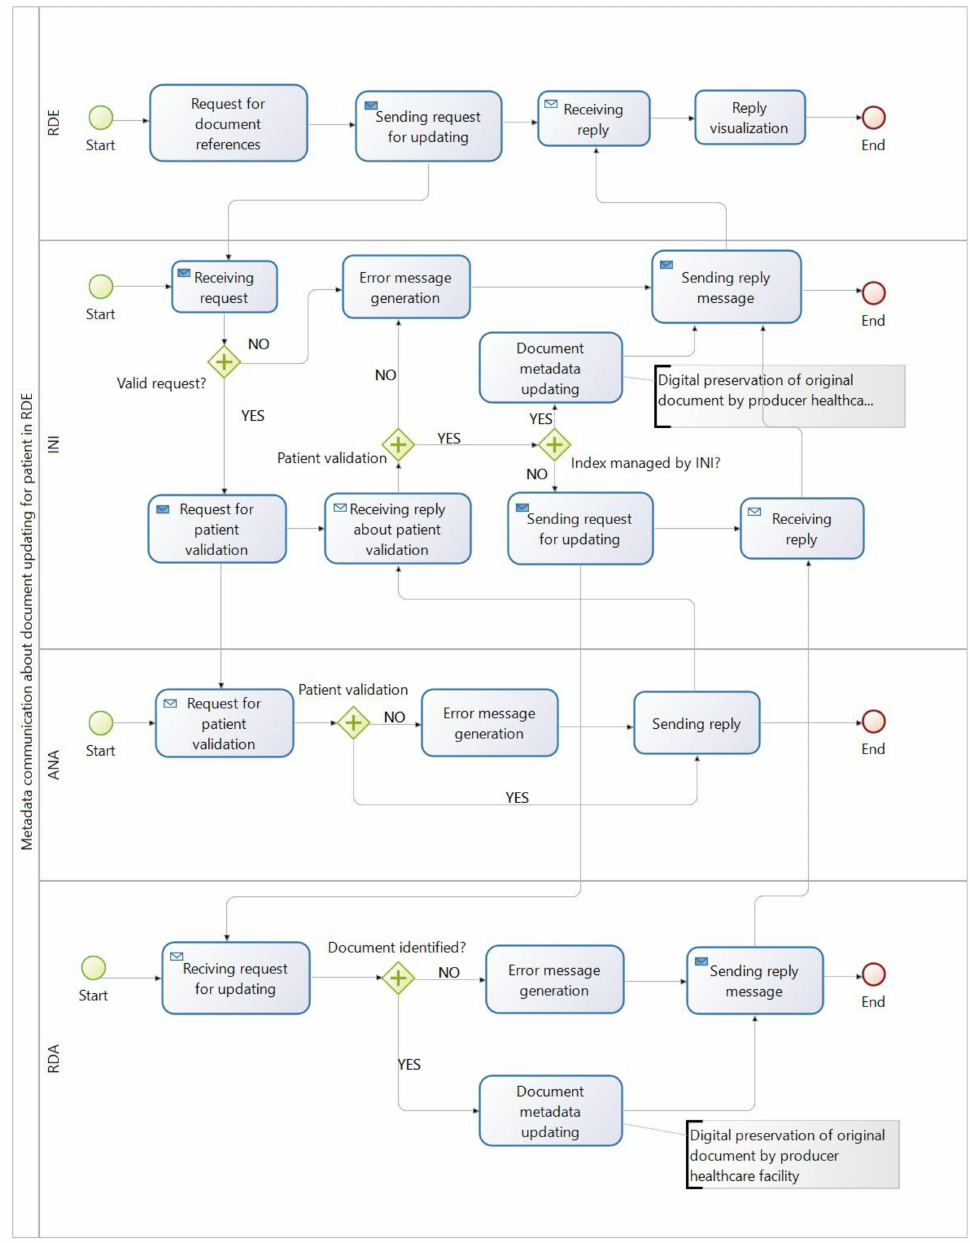
Figure 5. Metadata communication about document updating for a patient in the